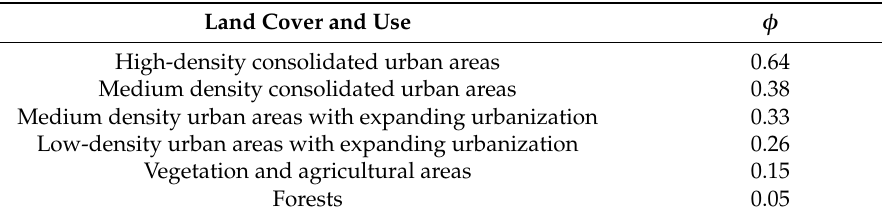
Table 1. Runo ff coe ffi cients as function land cover and land